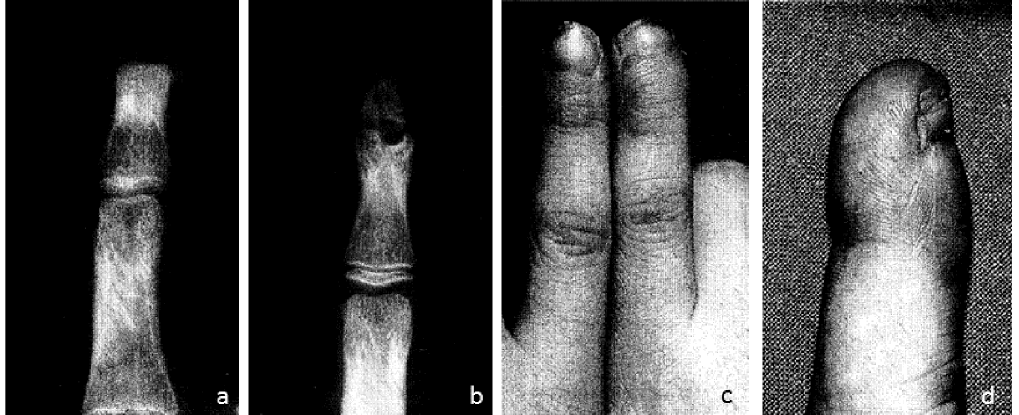
Figure 2. X-rays of patient at admission ( a ) and six months after the injury ( b ) showing regeneration of the distal phalanx. Photographs of the injured finger six months after the injury with left index finger for comparison ( c ) and close up ( d ) (Adapted from